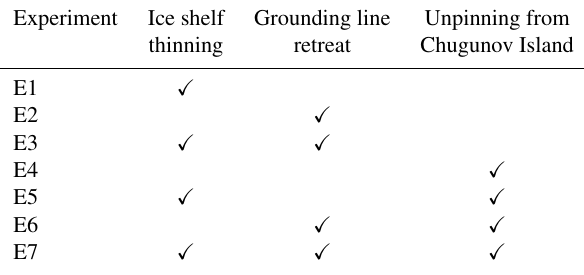
Table 1. Summary of the perturbations included in each of our seven numerical modelling